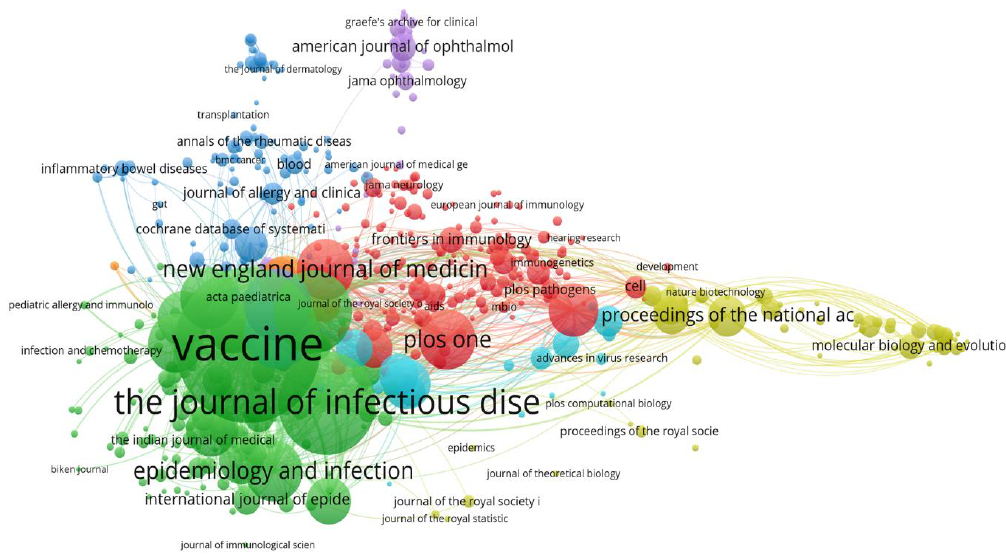
Figure 8. Outstanding sources contributing to rubella virus research.